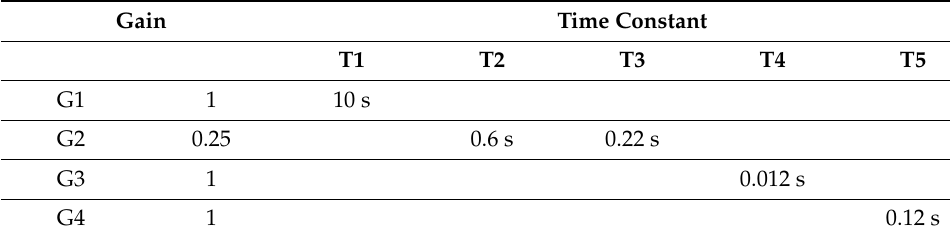
Table A3. Auxiliary controller.